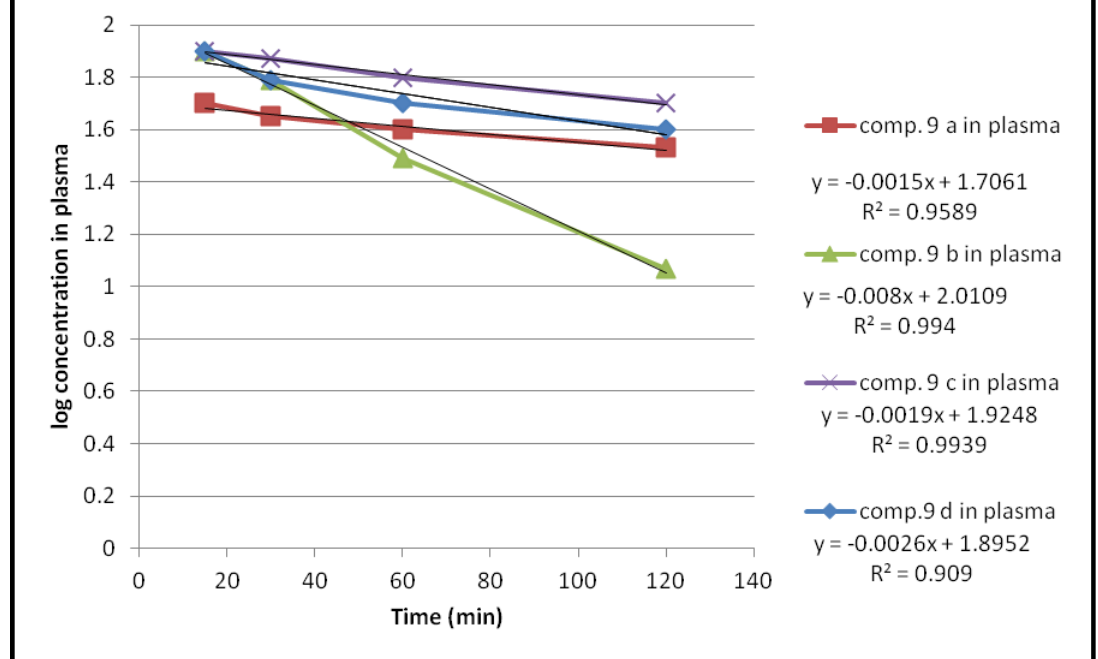
Figure 6. The hydrolysis rate of the compounds 9a–d in 80% human